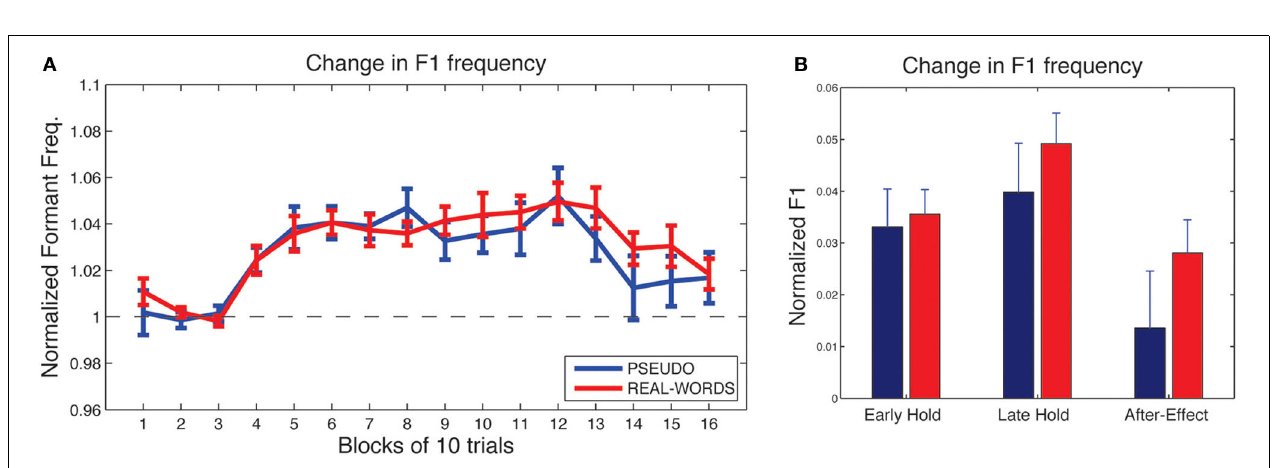
magnitude of the change in F1 is notably greater for LC-2 (blue line), compared with LC-1 (red line). (B) . Mean normalized F1 at three key time-points during the adaptation task.